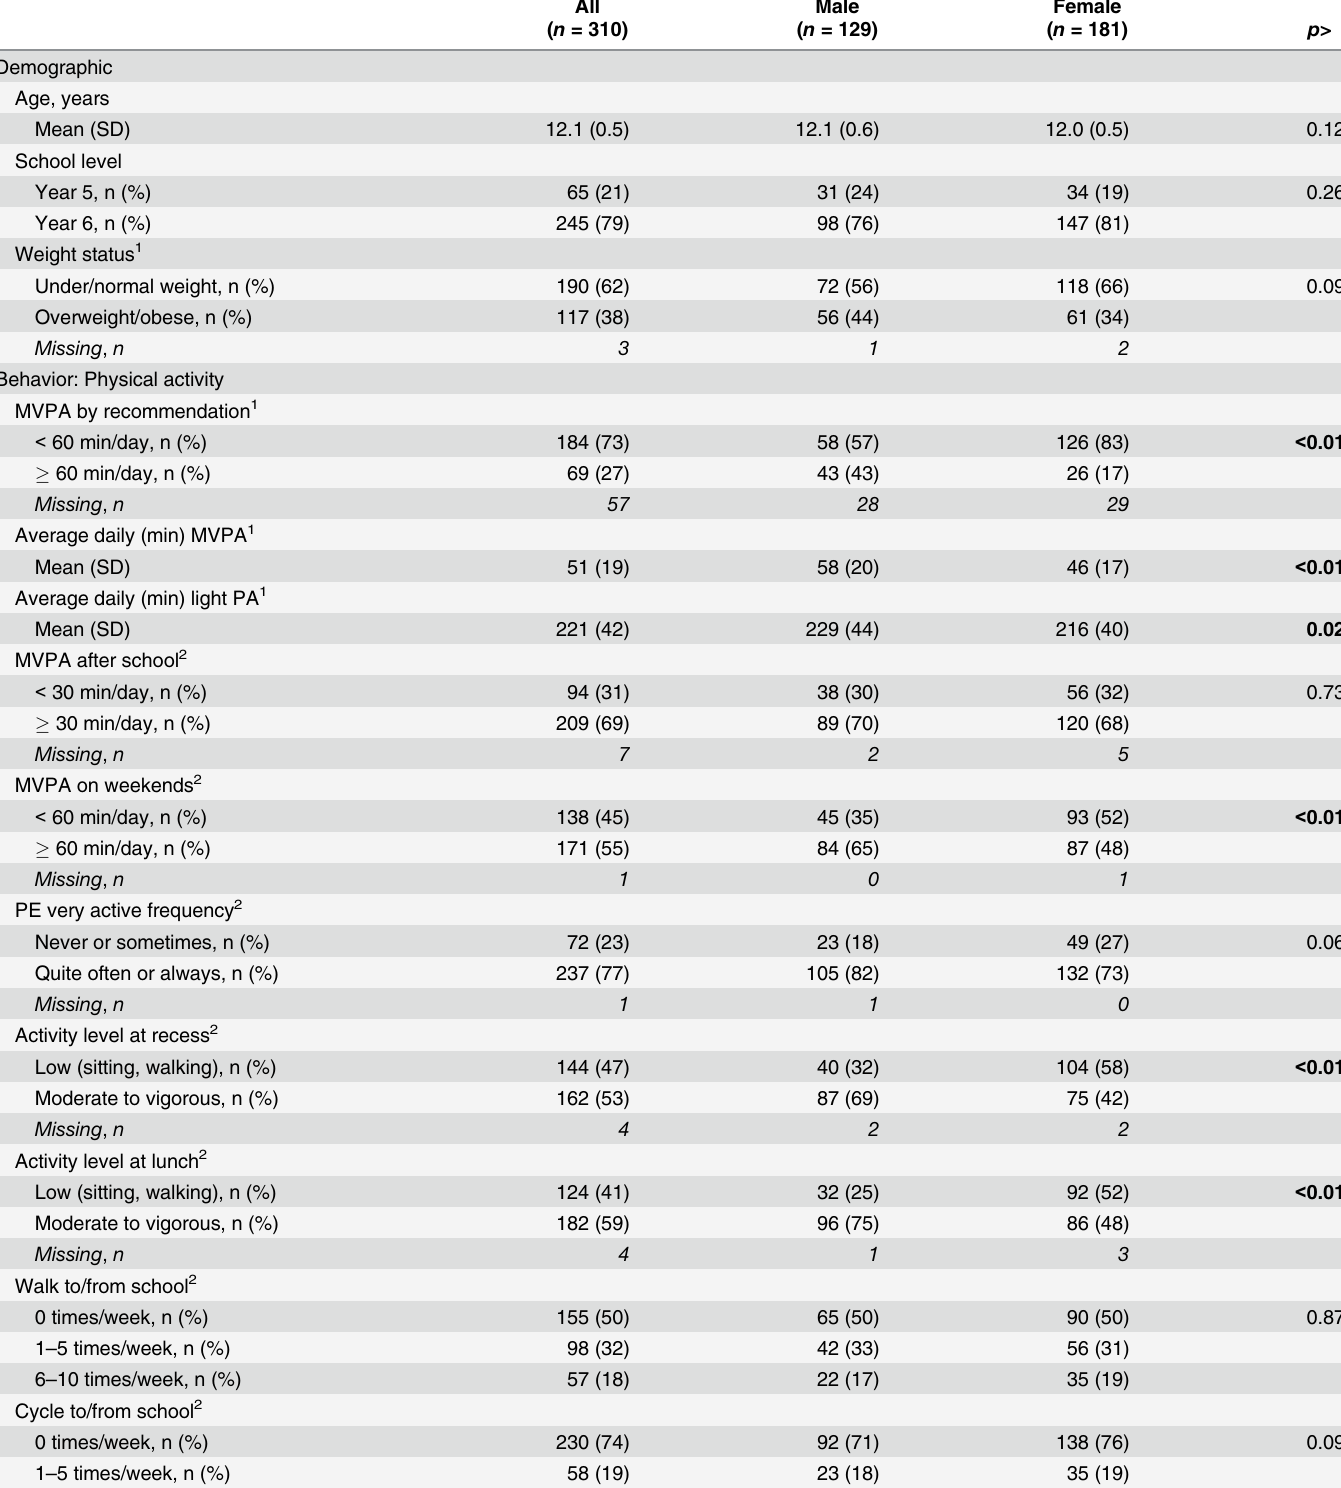
Table 1. Participant characteristics: demographic and